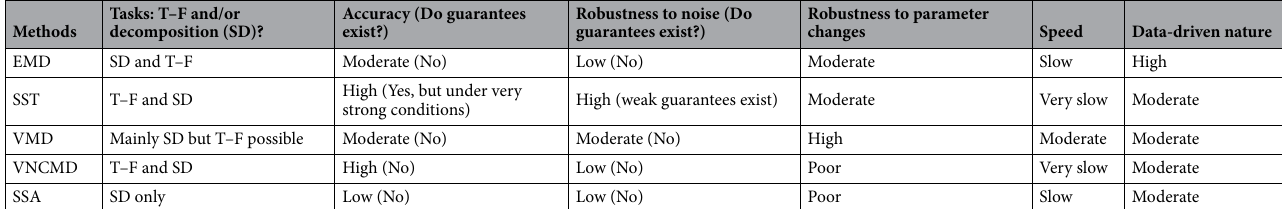
Table 1. Comparing the performance of the data-driven SD approaches in terms of task performed, accuracy, robustness to noise, robustness to changes in parameters, practical speed and data-driven